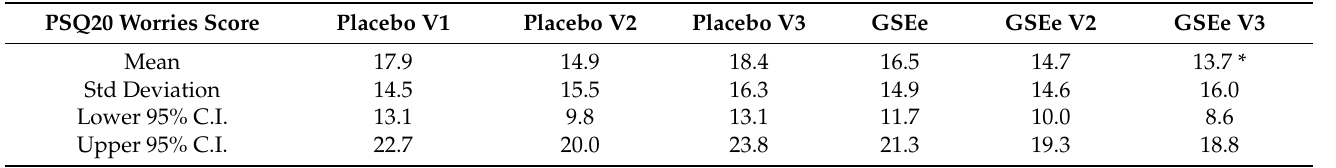
Table 3. Perceived Stress Questionnaire (PSQ20) worries